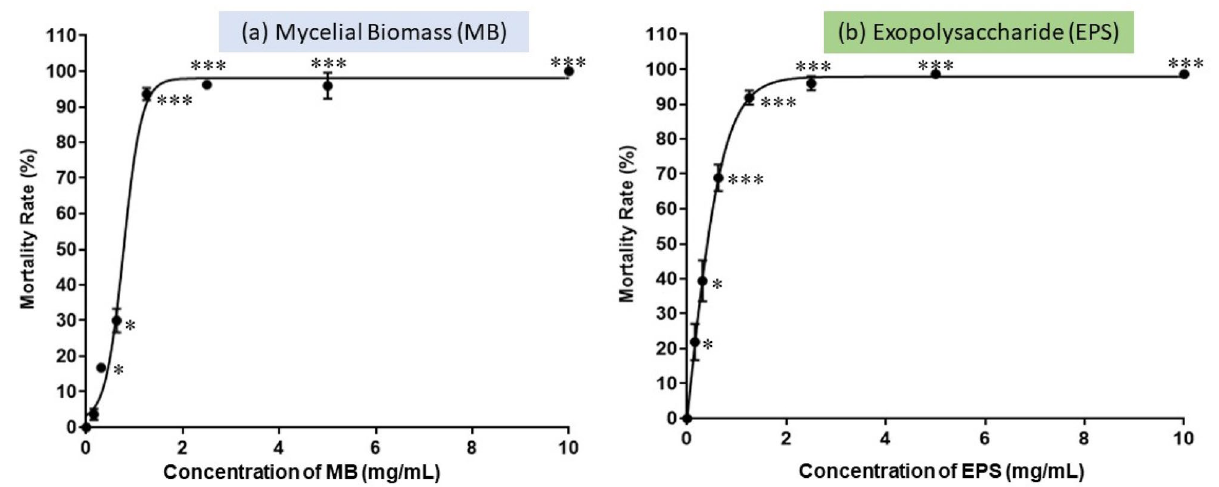
Figure 2. Effect of Tiger milk mushroom, Lignosus rhinocerus strain ABI ( a ) MB extract at concentrations of 0.16–10 mg/mL and ( b ) EPS at concentrations of 0.01–10 mg/mL on zebrafish embryos mortality rate after 120 HPF. Symbols: *** p < 0.001, ** p < 0.01 and * p < 0.05. The LC 50 value for MB extract was 0.77 mg/mL while LC 50 value for EPS extract was 0.41 mg/mL.